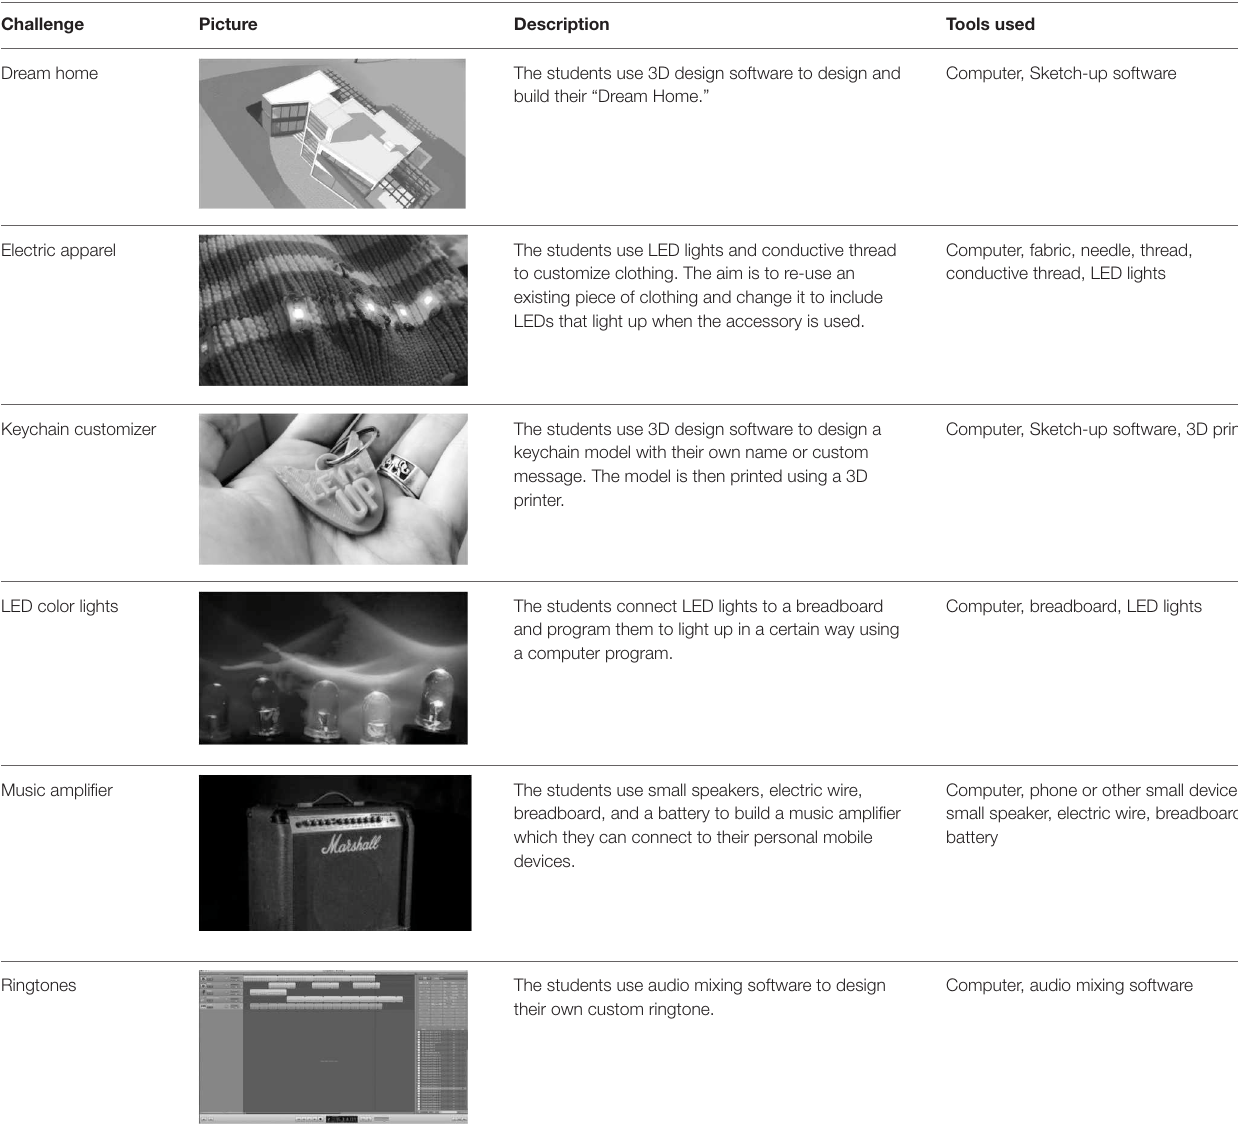
TABLE 1 | Description of the FUSE design